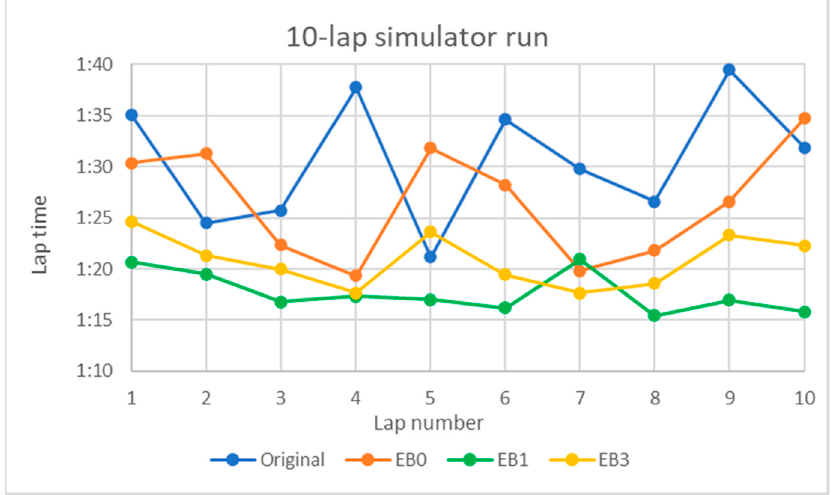
Figure 27. Lap time comparison over a 10-lap run on the driving simulator.